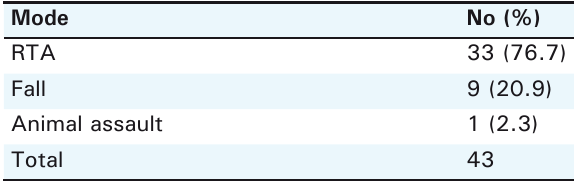
table 2. Mode of presentation